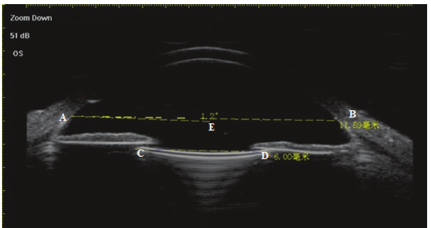
Figure 3: Measurement of IOL tilt (A, B = scleral spur, C, D = two optical endpoints of IOL, and line AE was the parallel line of line